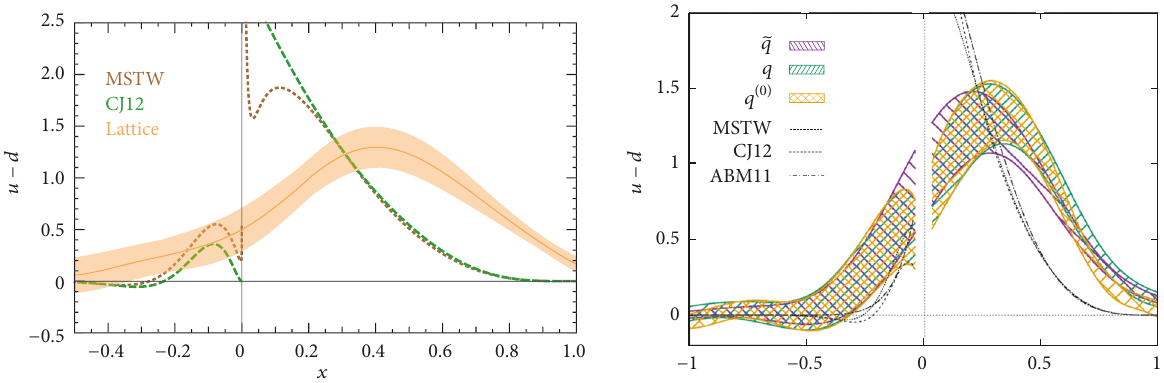
Figure 4: Final isovector unpolarized PDFs (shaded bands) at the largest employed nucleon boost, left: Lin et al., 1.29 GeV, right: ETMC, 1.42 GeV. The right plot also shows the quasi-PDF and the matched PDF before nucleon mass corrections. For illustration purposes, selected phenomenological parametrizations are plotted (dashed/dotted lines, no uncertainties shown) [102–104]. The errors are only statistical. Source: [46, 100], reprinted with permission by the Authors and the American Physical